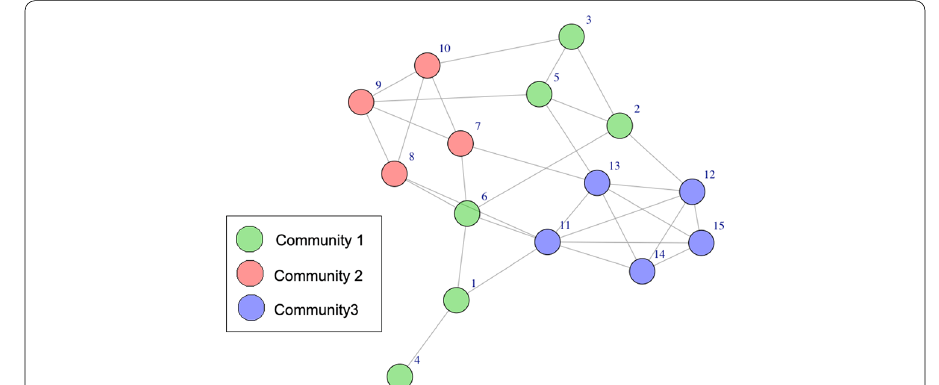
Fig. 1 Strong and Weak Community. An example of a strong and weak community network. The community in green is a weak community as it strictly violates the definition of strong community for each node. However the community in red can be viewed as a strong community if node 6 is ignored. In the case of the purple community, all the nodes strictly follow the definition of a strong community from